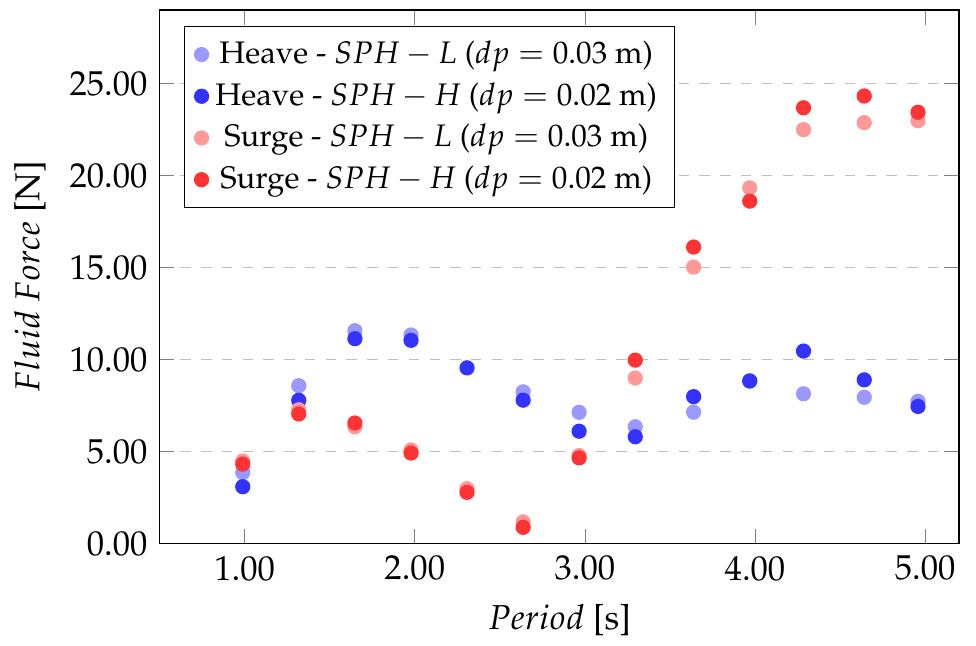
Figure 7. Sensitivity force test for the two resolutions.